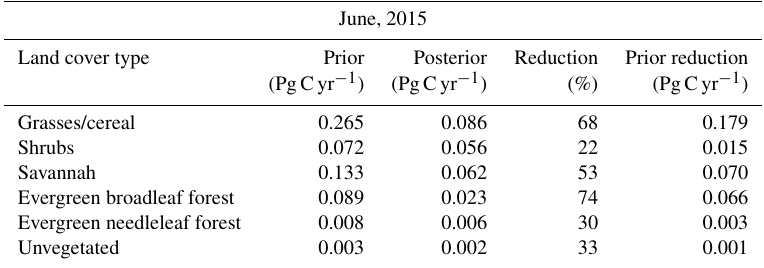
Table B3. Uncertainty reduction of total CO 2 Australian flux (in PgCyr − 1 ) classified by MODIS ecotype (September, 2015).